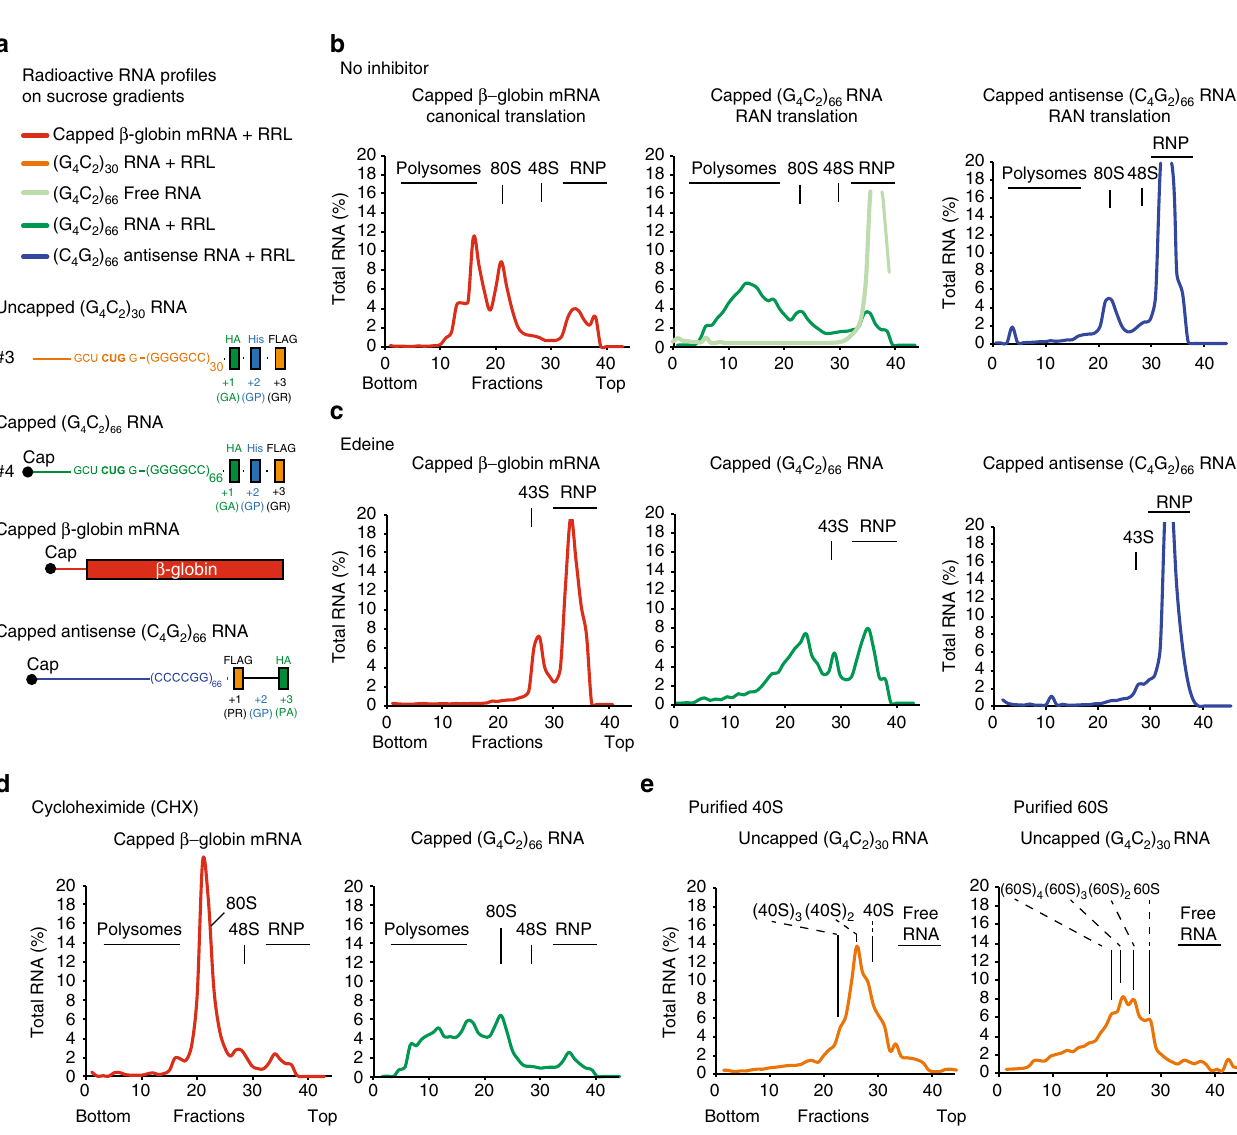
Fig. 7 G 4 C 2 containing transcripts have intrinsic ribosome binding capacity independently of their translation. ( a ) Scheme of the capped (G 4 C 2 ) 66 RNA (#4) and uncapped (G 4 C 2 ) 30 transcripts (#3) used for translation in RRL and polyribosome fractionation on sucrose gradients. As controls, capped β - globin and capped (C 2 G 4 ) 66 antisense repeat RNAs were used in the same system. ( b – d ) Radiolabeled capped (G 4 C 2 ) 66 RNA pro fi le by polyribosome fractionation in RRL comparatively to capped β -globin mRNA and (C 2 G 4 ) 66 antisense RNAs. Fractionation on sucrose gradients was performed without inhibitor ( b ), in presence of Edeine ( c ) or CHX ( d ). ( e ) Sucrose gradient fractionation of radiolabeled uncapped (G 4 C 2 ) 30 transcripts (#3) was performed